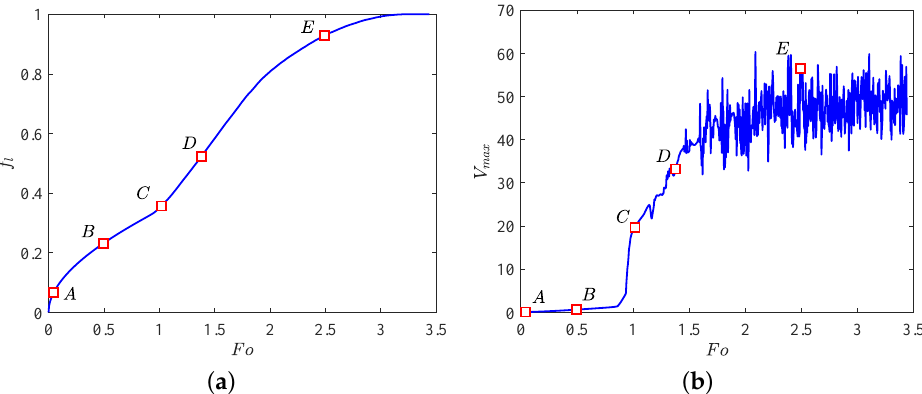
Figure 5. Time evolution of ( a ) the total liquid fraction f l and ( b ) the maximum flow velocity V max . Parameters: Ra = 0, T = 500, AR =